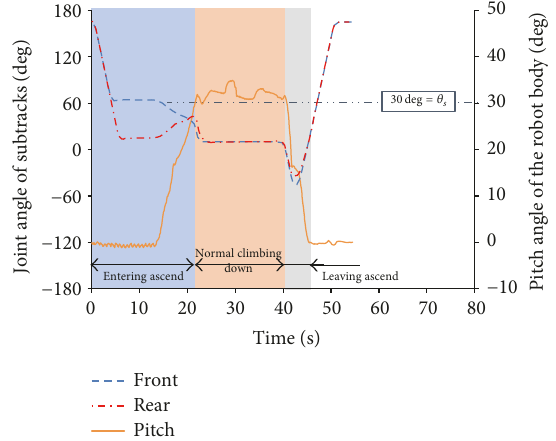
Figure 25: Data profile for 𝜃 𝑓 , 𝜃 𝑟 , 𝜃 𝑝 ( 𝜃 𝑠 = 30 ∘ , 𝑝 = 300 mm,